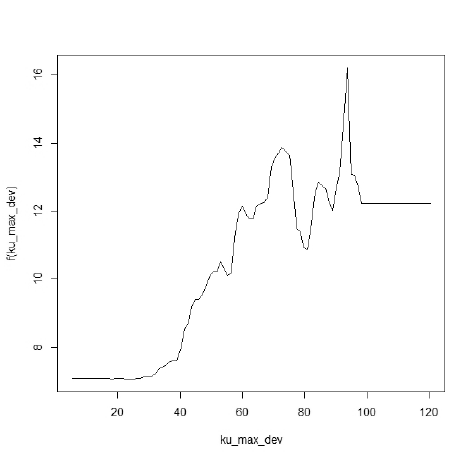
Figure 7: The PDP of maximum deviation of the strip in hot rolling shows the feature’s increasing risk on the